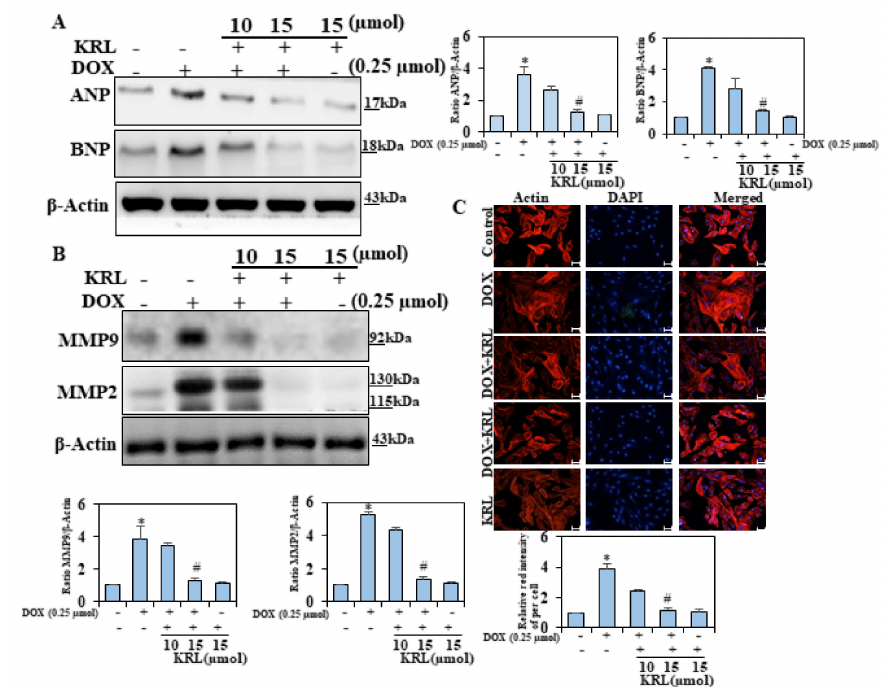
Figure 2. Effects of KRL on DOX-induced hypertrophy. H9c2 cells were treated for 24 h with 15 µ M of KRL, 2 h before DOX (0.25 µ mol) treatment. ( A ) Representative Western blots showing changes in the protein levels of ANP and BNP. ( B ) KRL is illustrated to downregulate MMP9 and MMP2. Western blot analysis was performed to determine the total protein MMP9 and MMp2 levels in the total extract by including β -actin as an internal loading control. ( C ) H9c2 cells were treated for 24 h with 10 and 15 µ M of KRL, 2 h before the DOX (0.25 µ mol) treatment. The cells then underwent actin filament staining to observe the changes in the surface area of the cardiomyocytes. Scale bar indicated 100 µ m at 20 × magnification. Data are represented as the mean ± SD of triplicate values ( n = 3) and * p < 0.05 represents significant variations compared with the control. # p < 0.05 represents significant variations as compared to DOX alone and KRL with DOX treatment